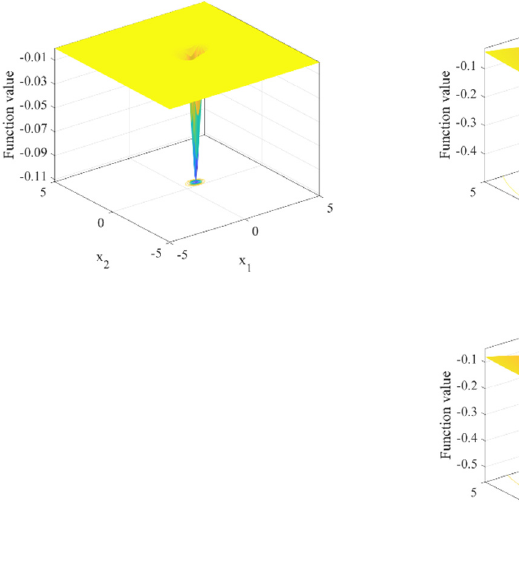
( c ) 2D shape of fixed-dimension multimodal benchmark functions Figure 3. Landscapes of benchmark functions. Figure 3. Landscapes of benchmark functions. Table 2. Multimodal benchmark functions.